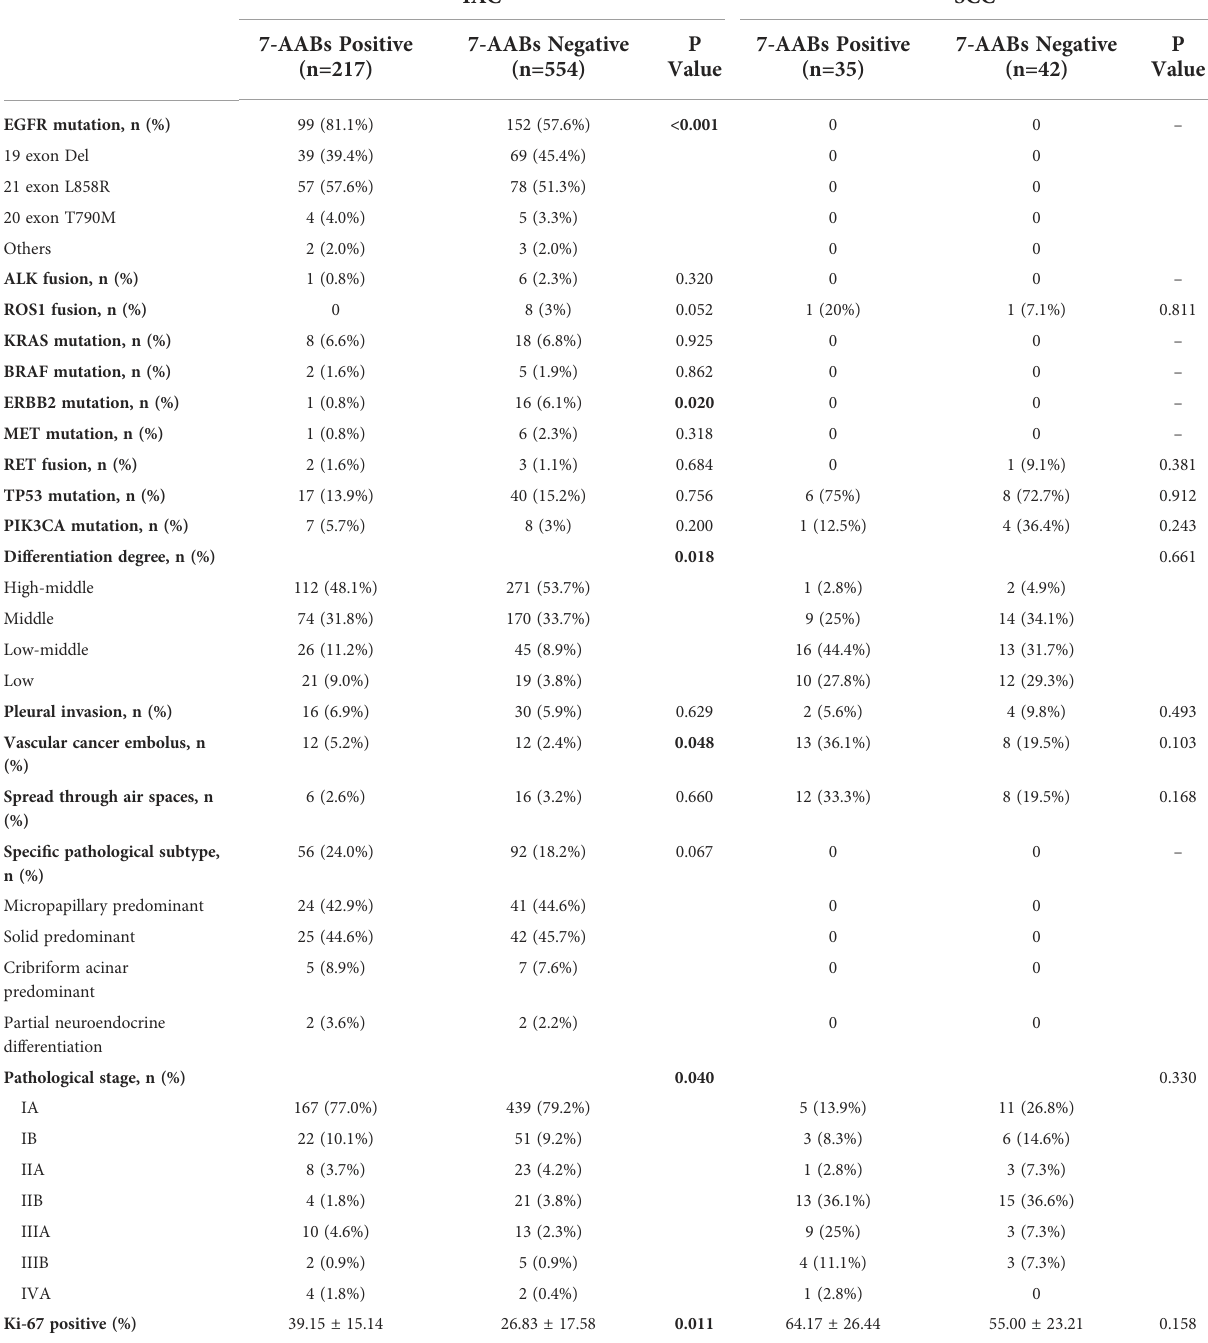
TABLE 3 Baseline clinical characteristics of patients with positive or negative 7-AAB test